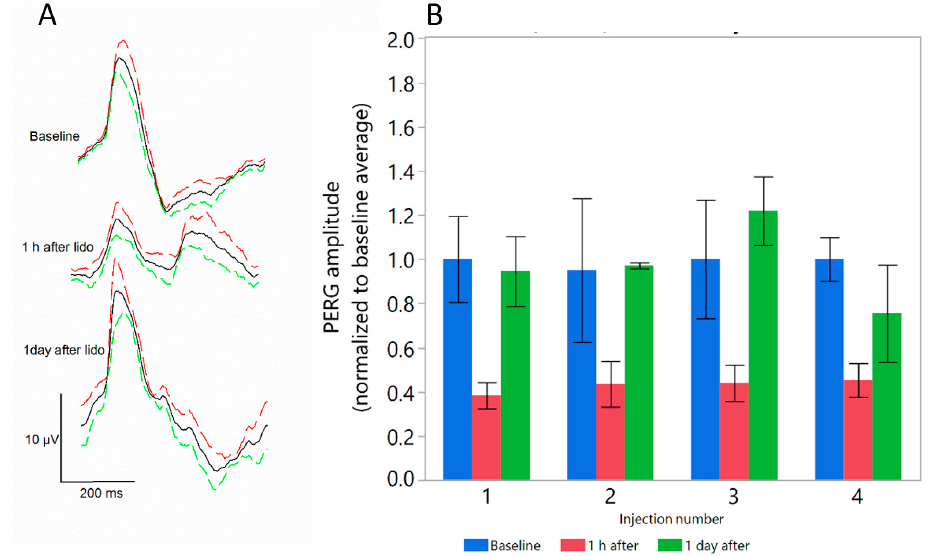
Figure 2. Retrobulbar lidocaine reversibly reduces Pattern Electroretinogram (PERG). ( A ) PERG waveforms in DBA/2J mice before and at different times after injection. Continuous black lines represent the grand-average waveform of all mice tested, and colored dashed lines represent the superior (red) and inferior (green) 95% confidence interval of the mean; ( B ) Peak-to-trough PERG amplitude decreases by about 60% one hour after lidocaine but recovers baseline values one day after injection. The effect is repeatable after four injections four days apart. Bars represent the mean ± SEM ( N = 5).